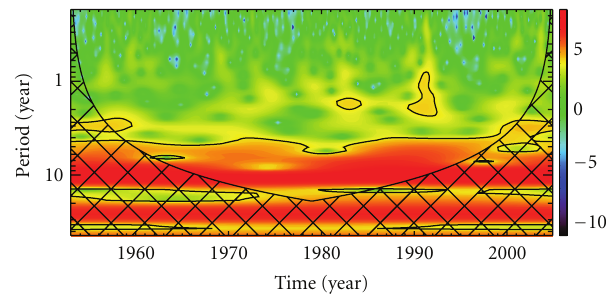
Figure 1: WPS of CLI data by using the Morlet mother wavelets. Black contours correspond to the 80% confidence level. The WPS is meaningless inside the the cone of influence (cross-hatched region). The following parameters have been used: frequency resolution δ j = 0 . 125, Morlet wavelet nondimensional frequency, w = 6; s = 2 months is the smallest resolvable scale and J = 8 /δ j 0 0 determines the largest